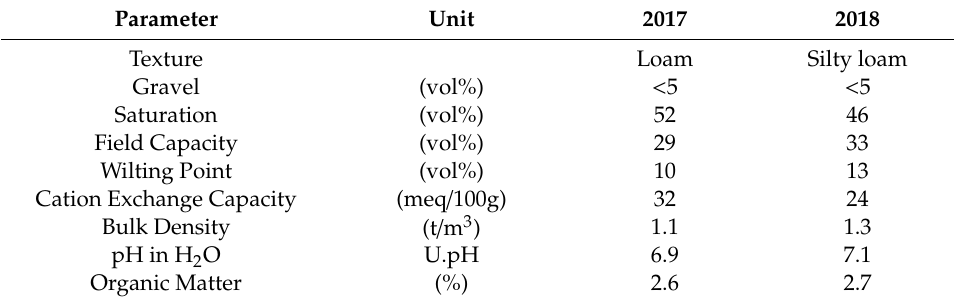
Table 1. Main soil characteristics of the two soils.